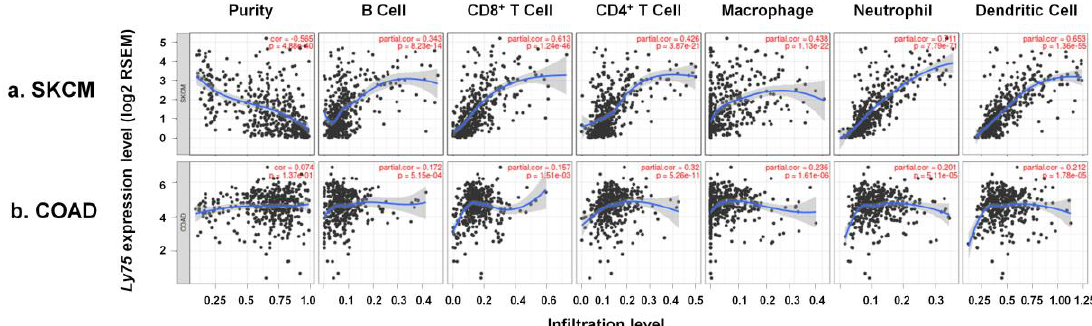
Figure 4. Association of Ly75 expression with immune cell infiltration in SKCM and COAD. Scatter plots were generated using with the Tumor Immune Estimation Resource (TIMER) web tool (https: // cistrome.shinyapps.io / timer / ) to identify the immune cell profiles that are associated with Ly75 expression in ( a ) SKCM and ( b ) COAD of the TCGA database. Correlation constants and p -values are detailed in Supplementary Table